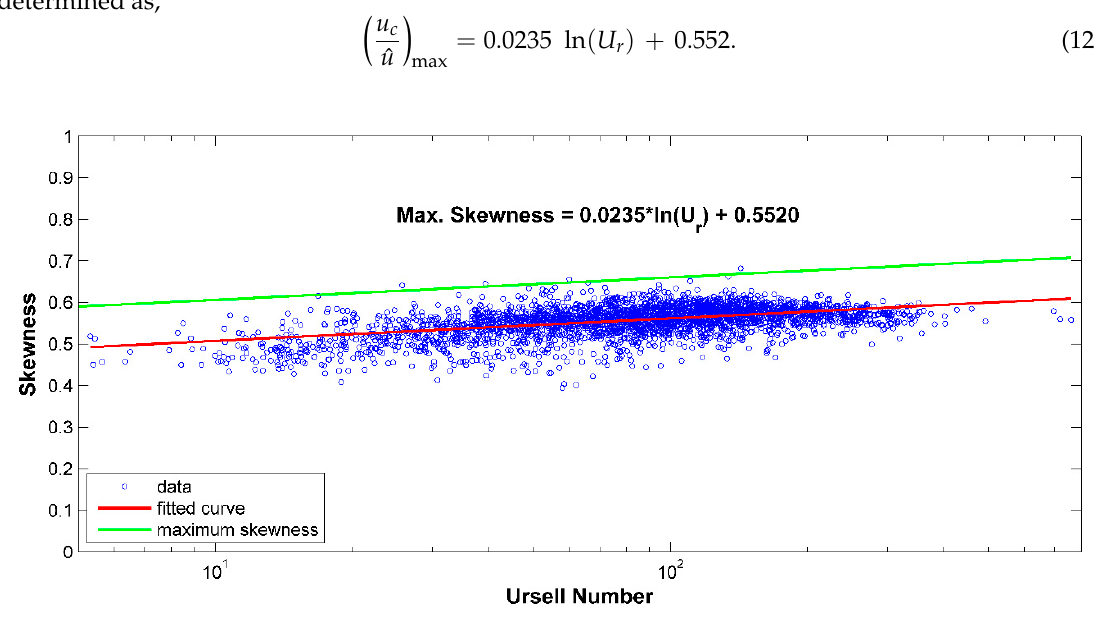
Figure 5. Relationship between velocity skewness and the Ursell number.